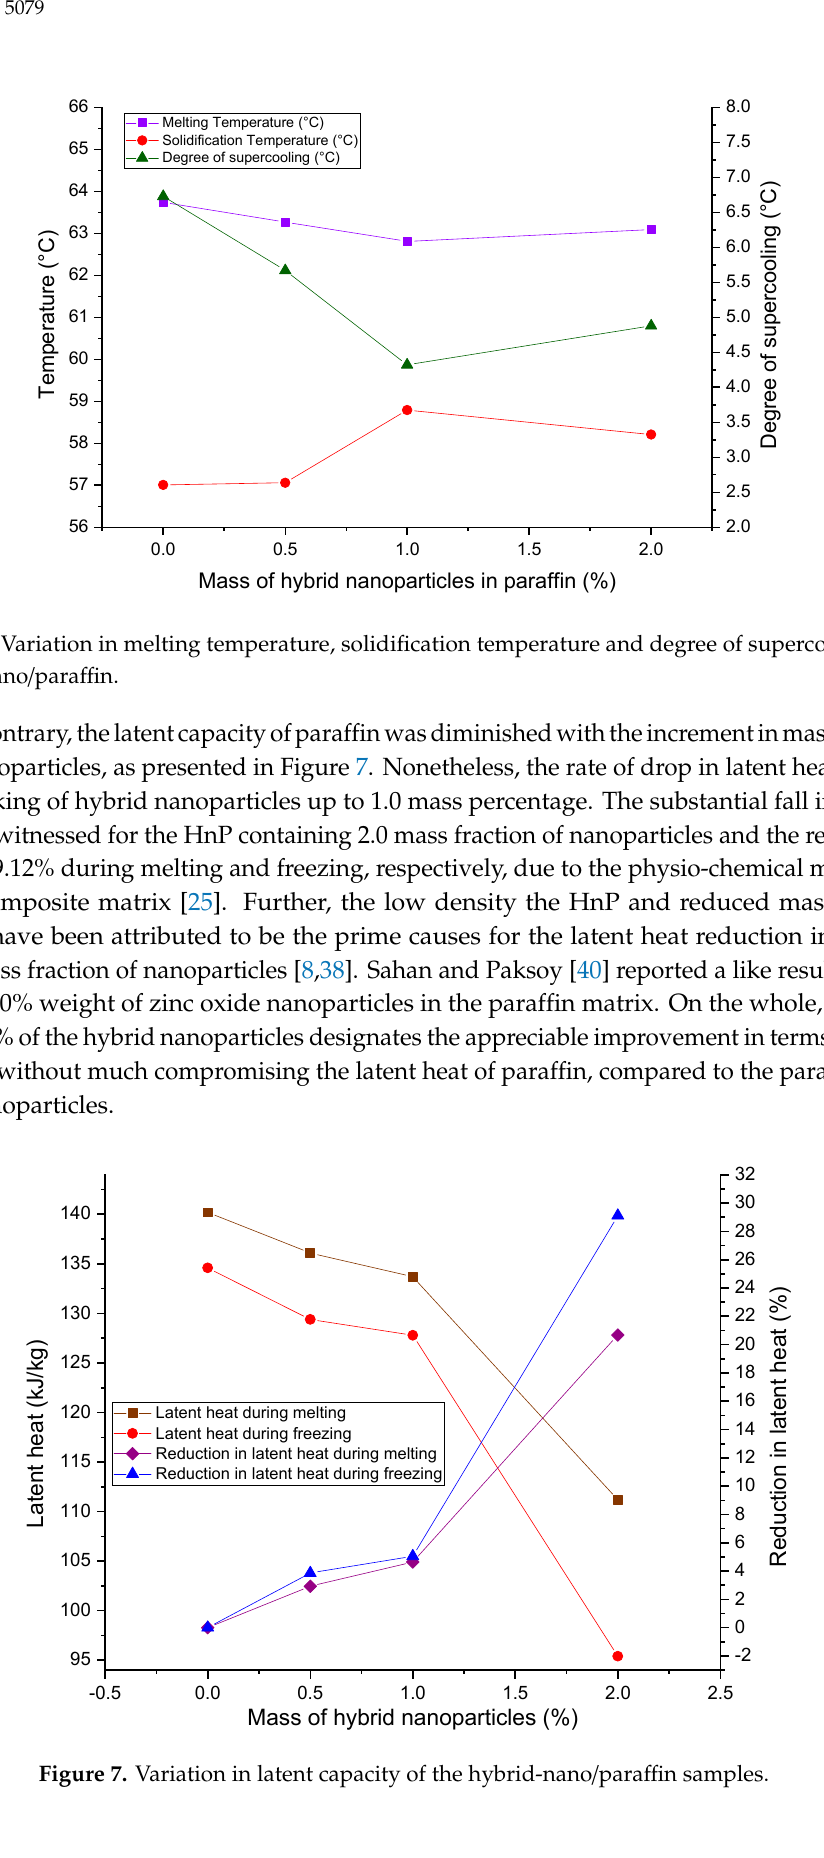
9 of 16 Figure 5. DSC results of the hybrid-nano/paraffin samples. Table 3. Thermal properties of hybrid-nano/paraffin samples assessed with DSC. Sample Name